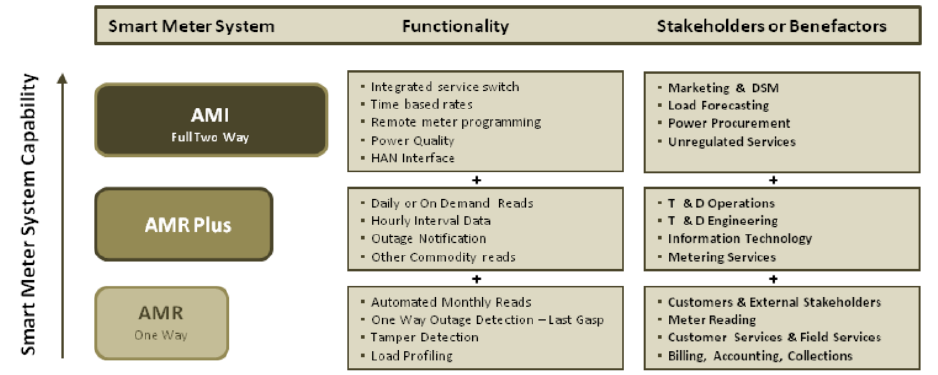
Figure 1. Evolution of Smart Metering [8]. Reprinted with the permission of the Edison Electric Institute, “Smart Meters and Smart Meter Systems: A Metering Industry Perspective”, published by the Edison Electric Institute,